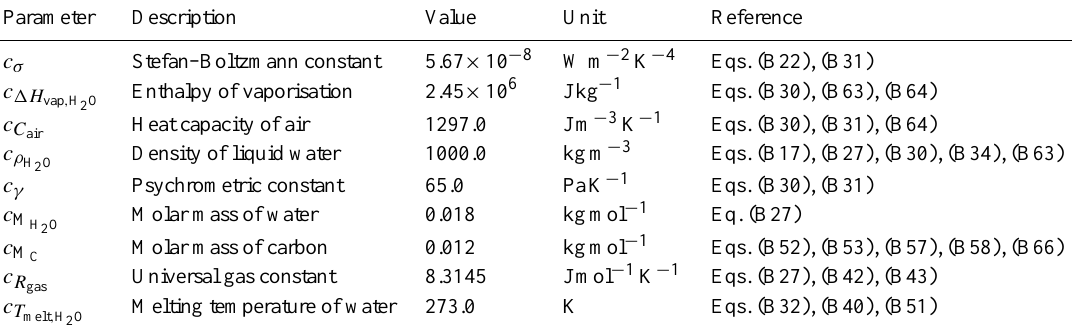
Table B7. Overview of natural constants used in the model.